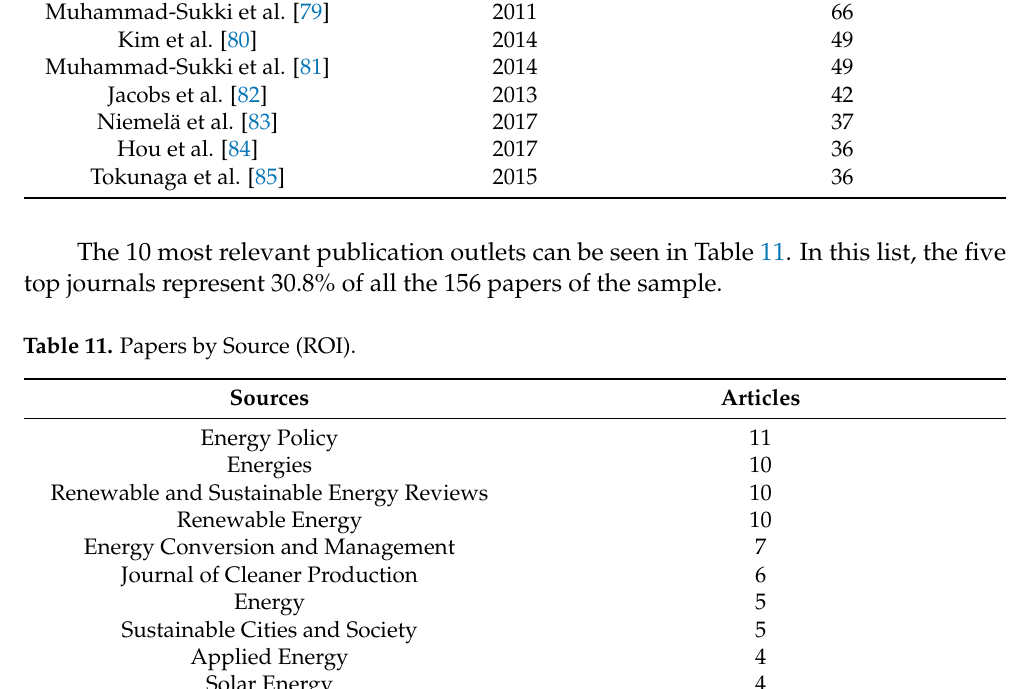
Table 10. Most Cited Papers (ROI).